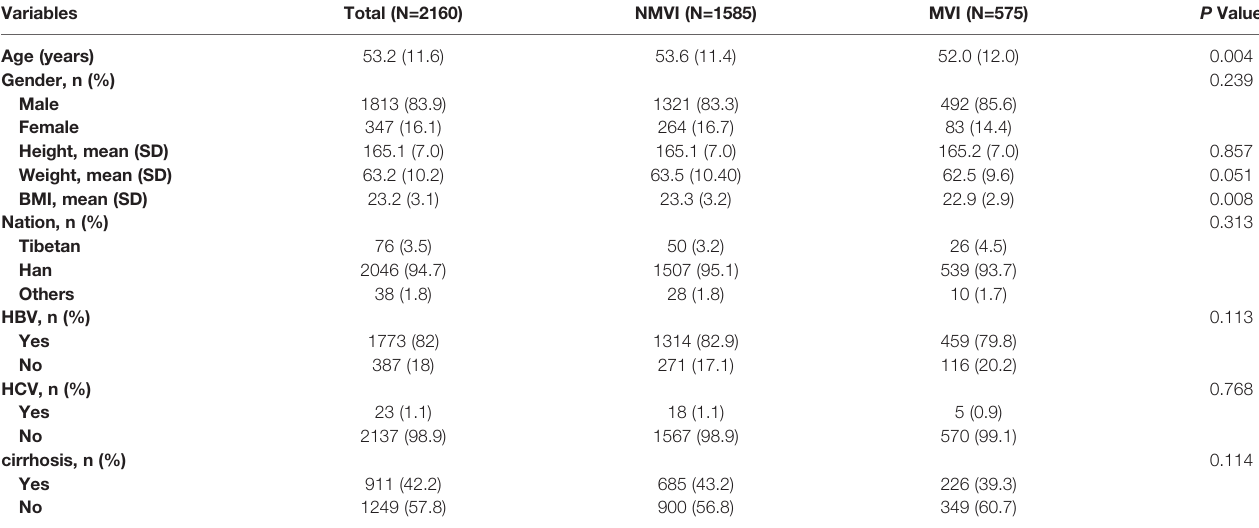
TABLE 1 | The participant baseline characteristics